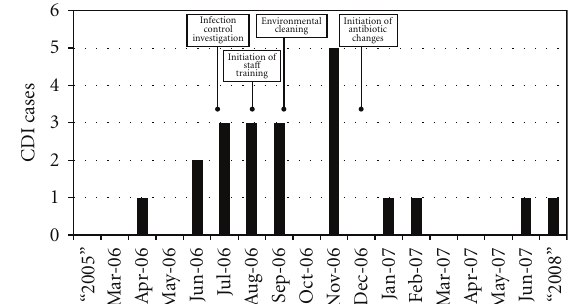
Figure 1: Clostridium di ffi cile infection outbreak timeline and